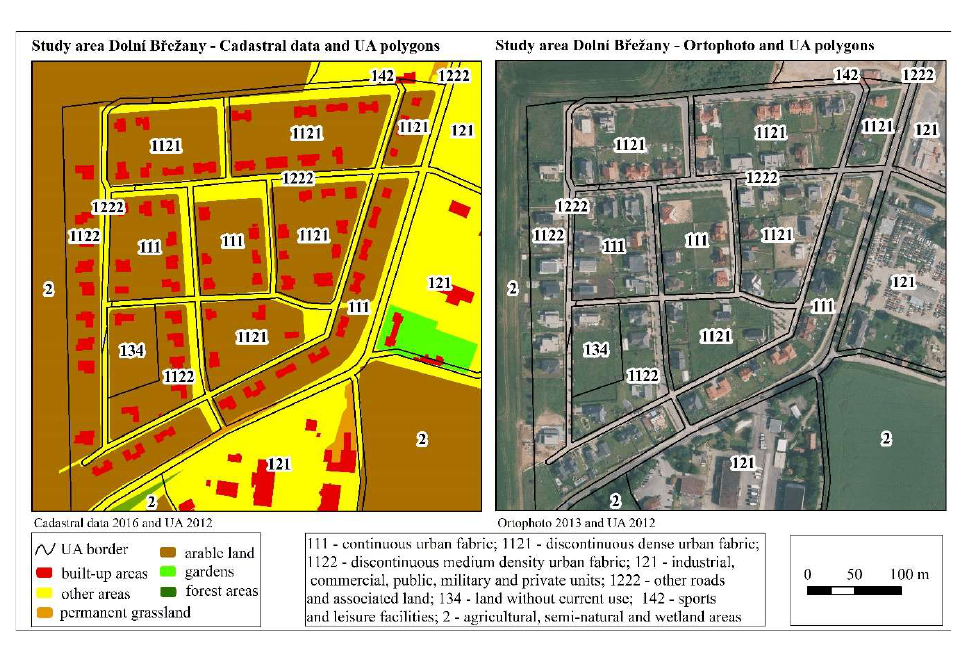
Figure 9. Map of the CU Dolní Břežany. The colour symbolises the KN nomenclature: red 13, yellow 14, brown 2, black polygon UA. Source: [32,34,36]. 14, brown 2, black polygon UA. Source: